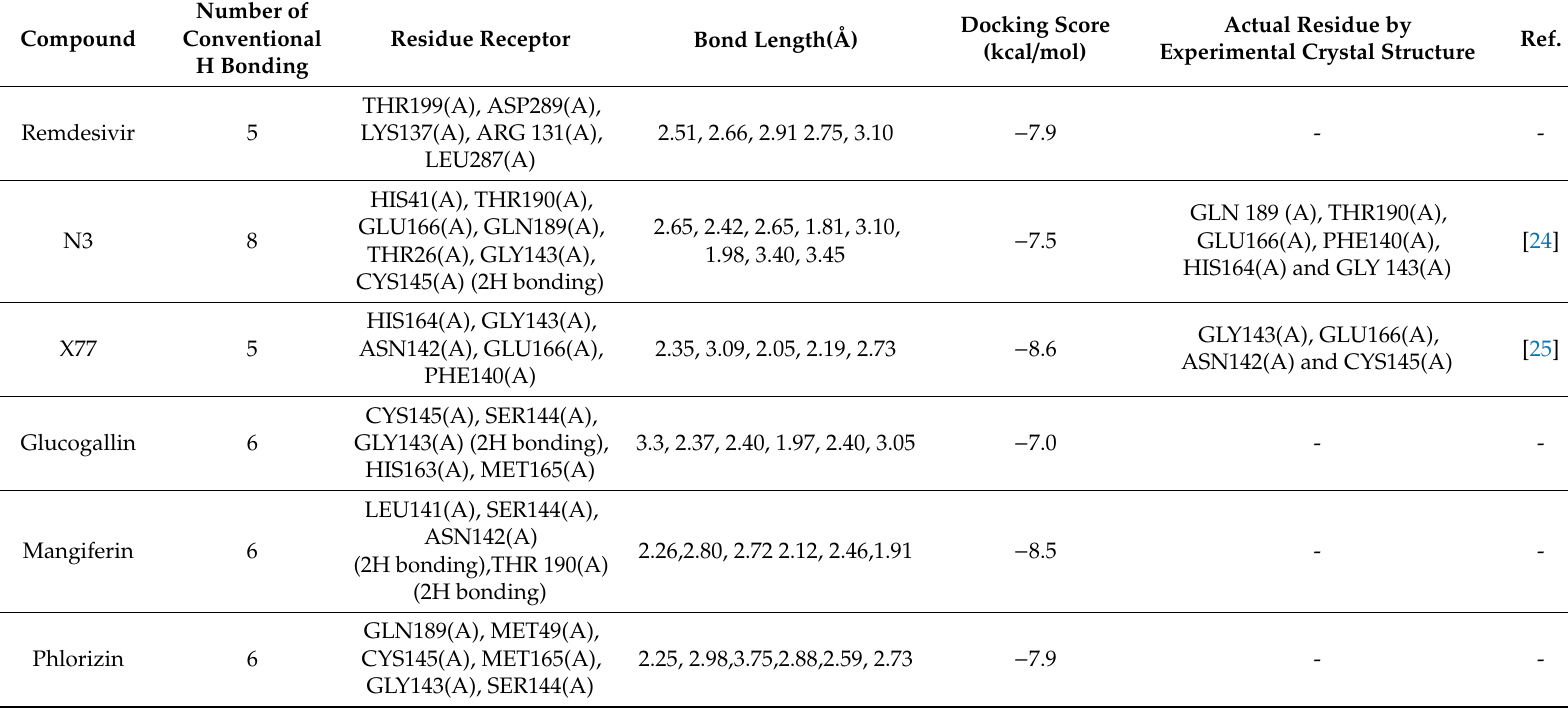
Table 1. Predicted interactive residues of SARS-CoV-2 main protease with